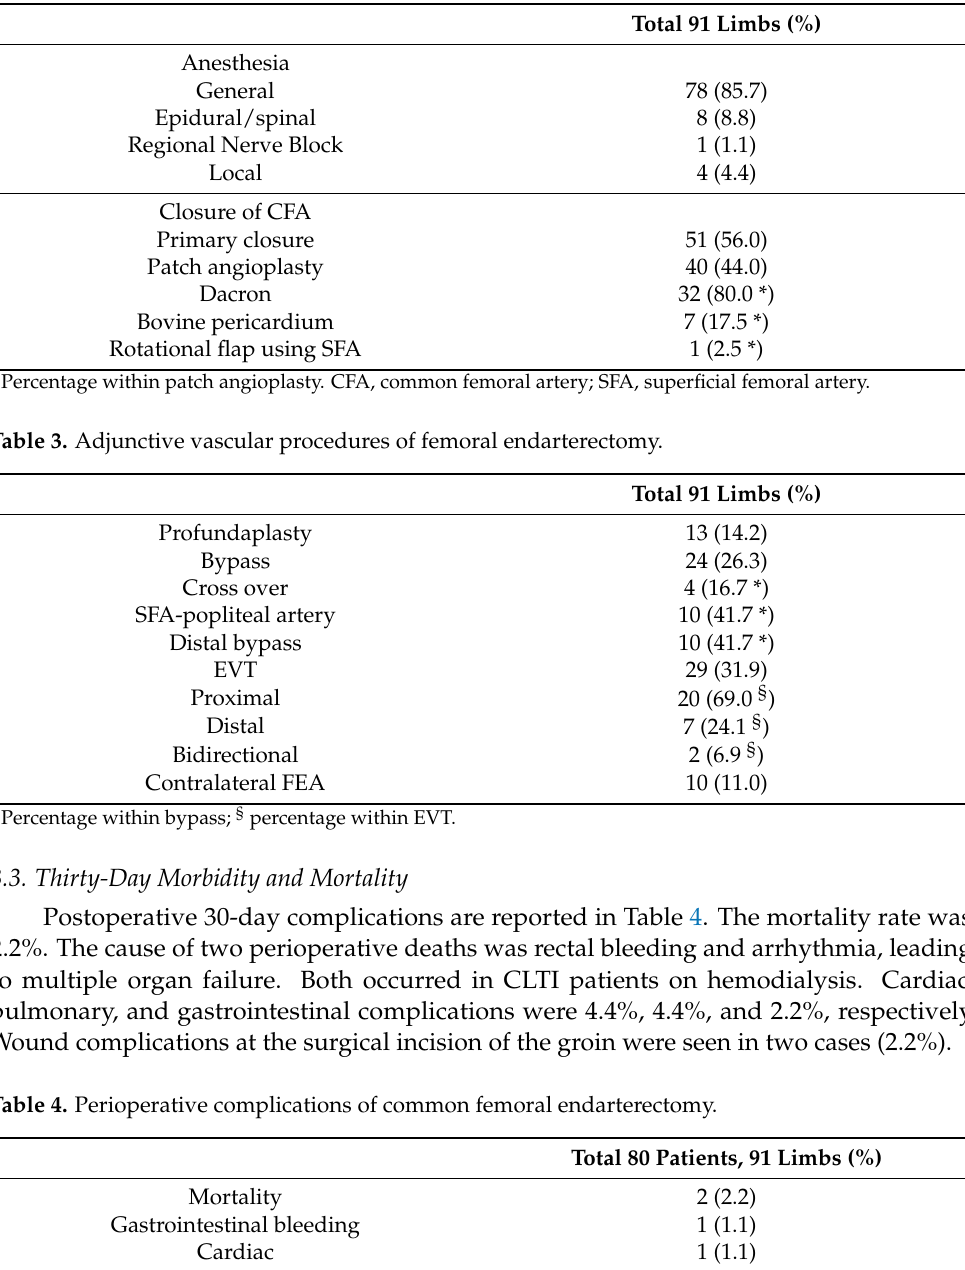
Table 2. Operative details of femoral endarterectomy.